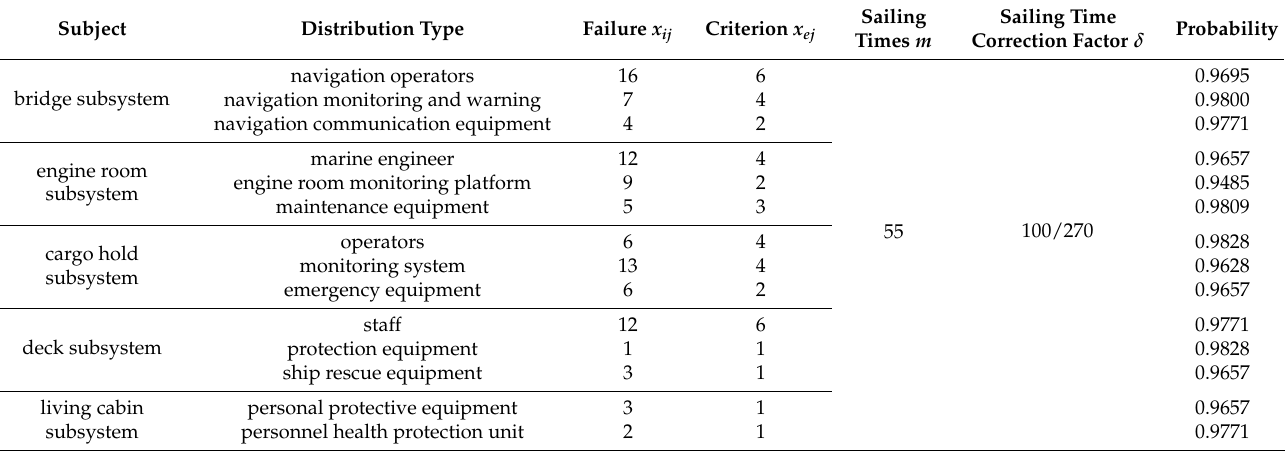
Table 13. Statistical data of maintenance records of the tested ship in the past 1 year.